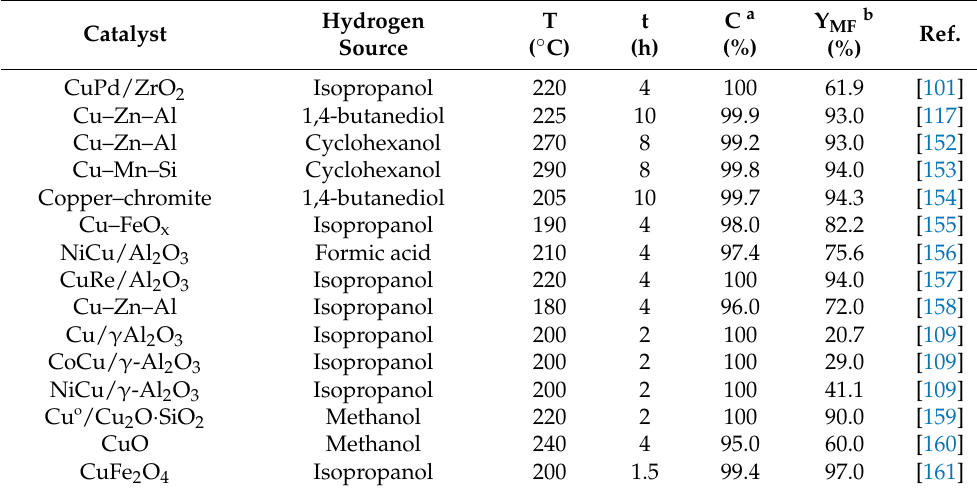
Table 3. Catalytic activity of Cu-based catalysts for conversion of FUR to MF through CTH.